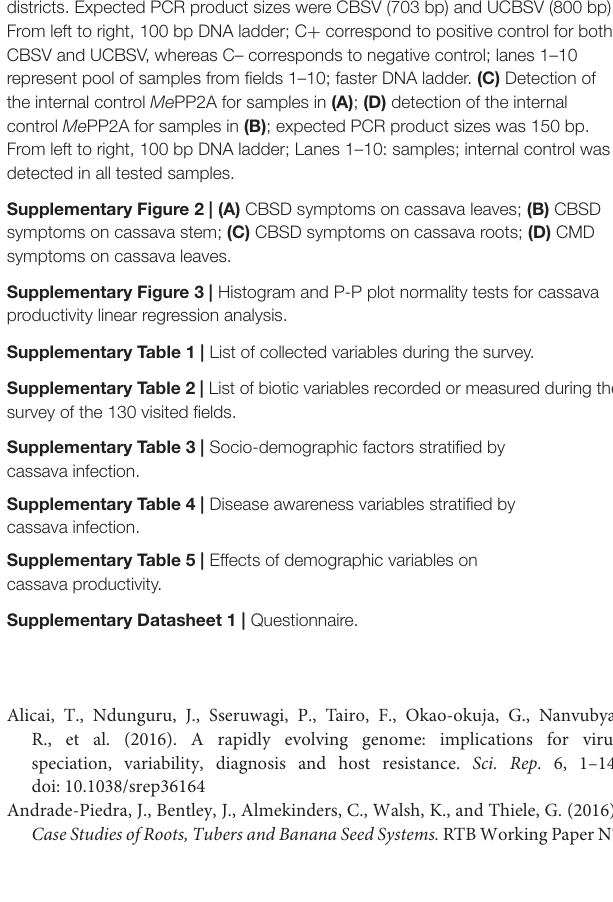
Supplementary Table 1 | List of collected variables during the survey. Supplementary Table 2 | List of biotic variables recorded or measured during the survey of the 130 visited fields. Supplementary Table 3 | Socio-demographic factors stratified by cassava infection. Supplementary Table 4 | Disease awareness variables stratified by cassava infection. Supplementary Table 5 | Effects of demographic variables on cassava productivity. Supplementary Datasheet 1 |